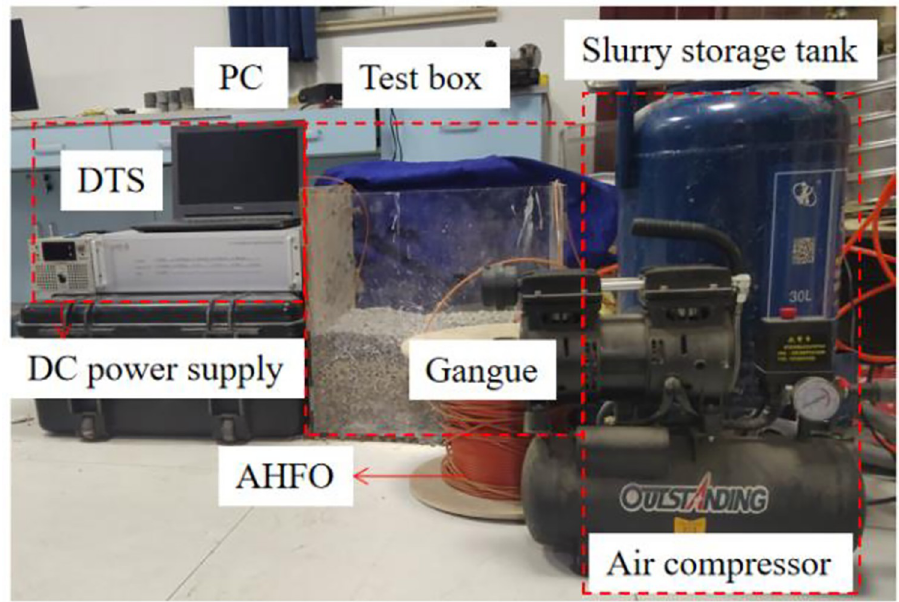
Fig 2. Test platform for coal gangue slurry diffusion in